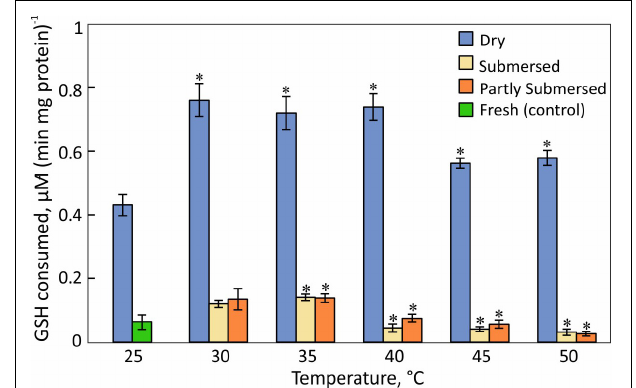
FIGURE 10 | H 2 O 2 -dependent glutathione oxidation activity in dried and partially and fully submersed Pleopeltis fronds exposed to different temperatures for 24 h. The activity of heat treated dry and hydrated fronds is compared with 25 ◦ C dry and fresh (control), respectively. Significant differences between treated and controls are indicated by ∗ ( P ≤ 0.05); means ± SE, n =